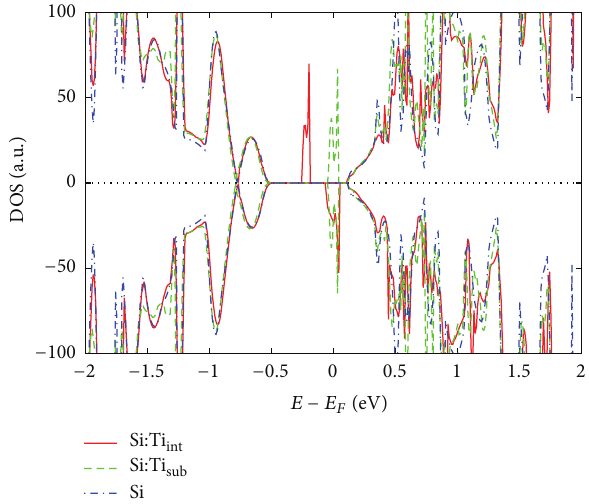
Figure 1: Calculated density of states for interstitial (Ti int ) and substitutional (Ti sub ) Ti in Si compared with that of bulk